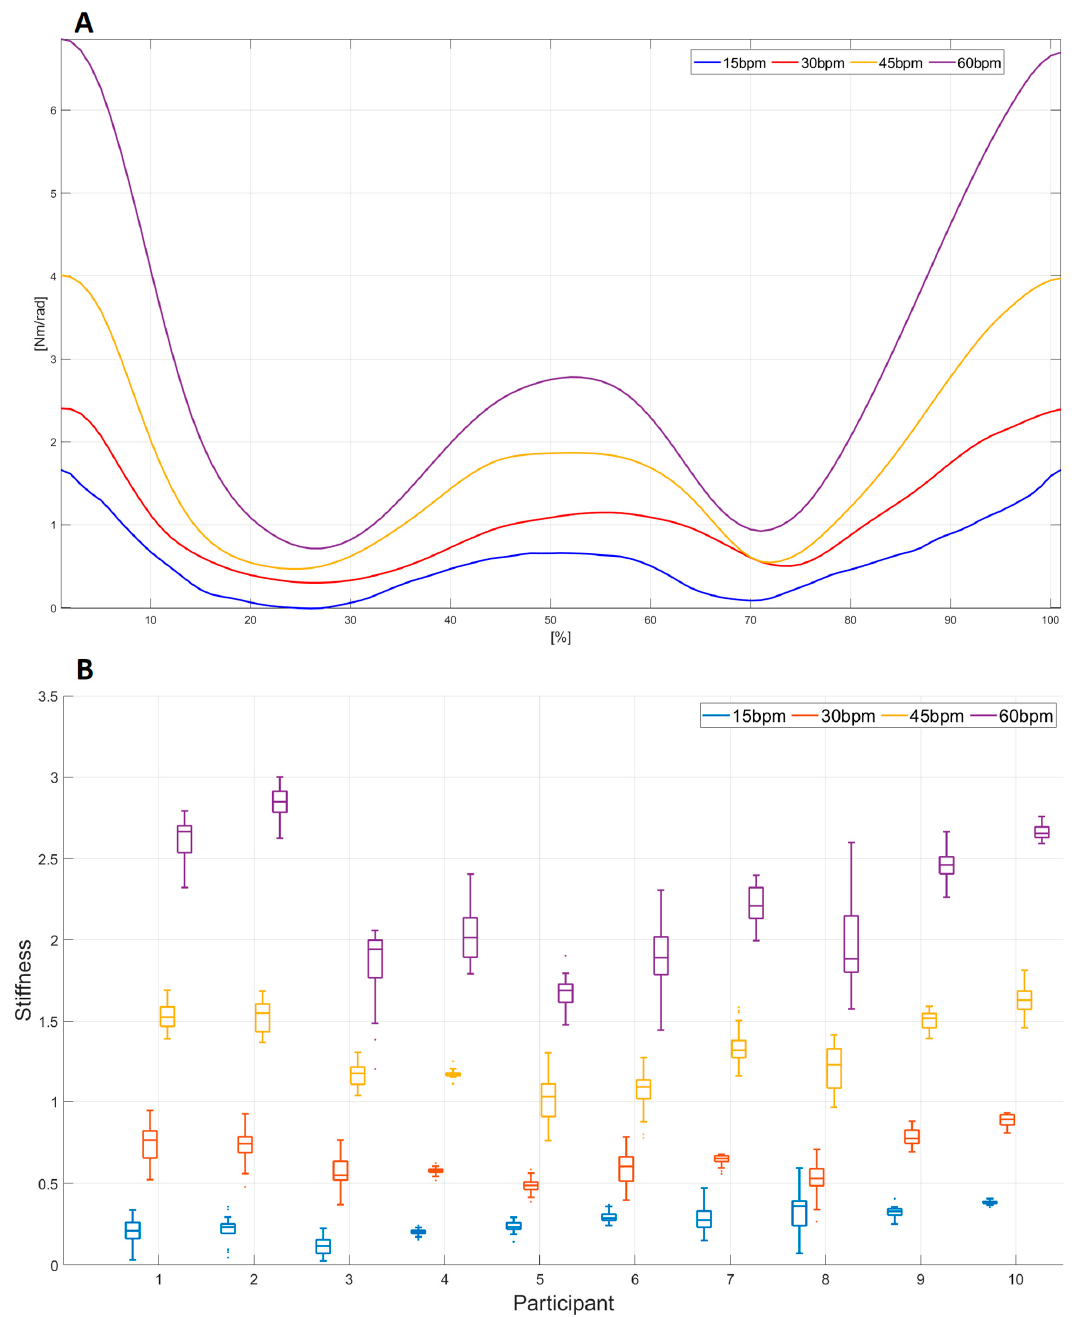
Figure 6. Comparative analysis of ( A ) elbow joint stiffness mean value for participant 9; ( B ) stiffness value for each tempo for all 10 participants in task E1.